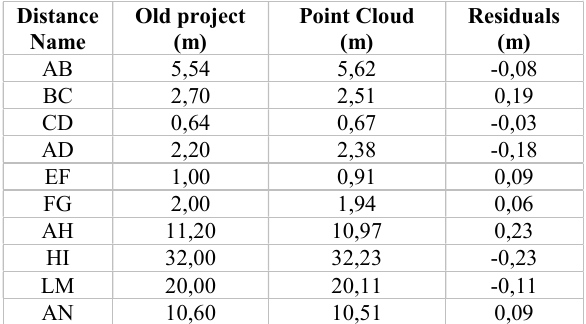
Figure 7. Measure extracted from the old project in façade